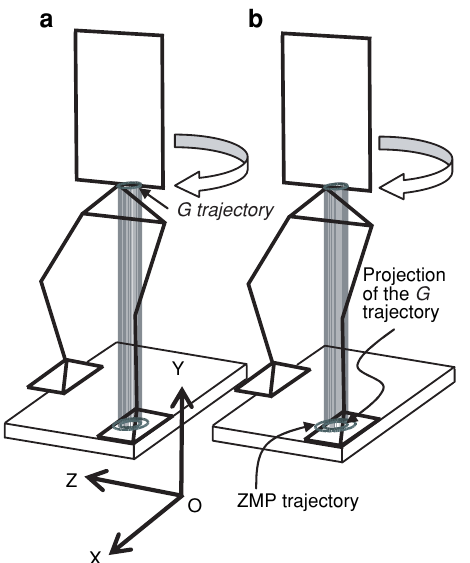
Figure 5 (a) The biped keeps the balance, (b) the biped falls.